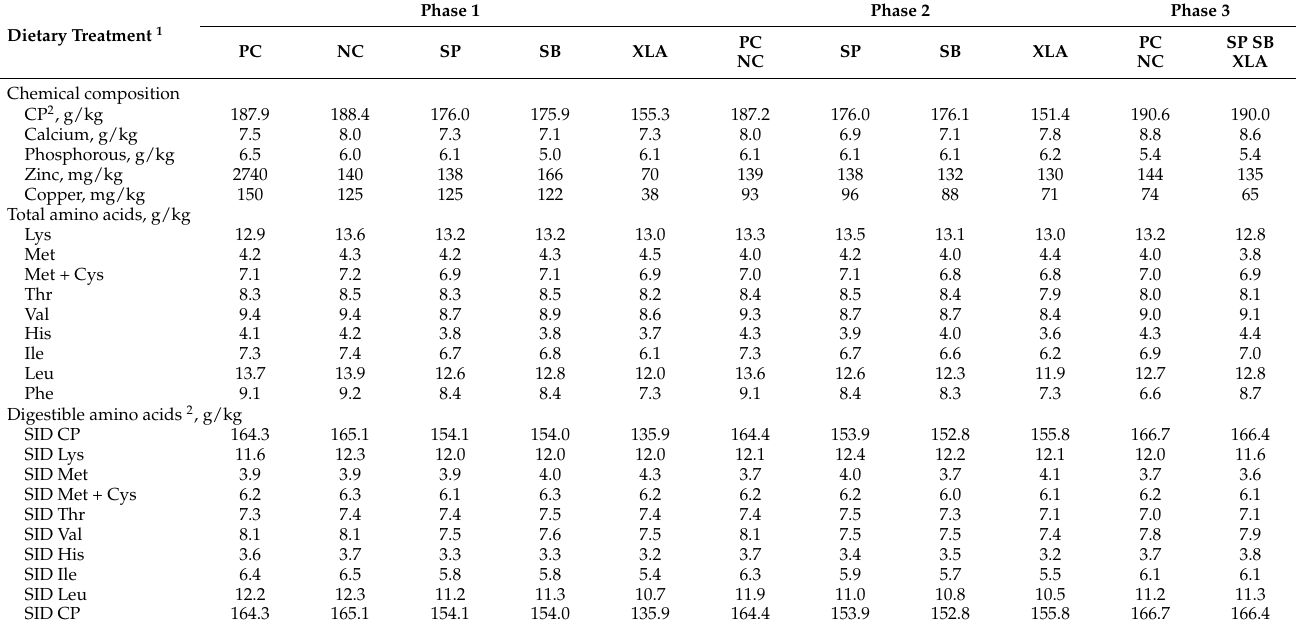
Table 1. Analysed nutritional contents of the five experimental diets in the three feeding phases for weaned